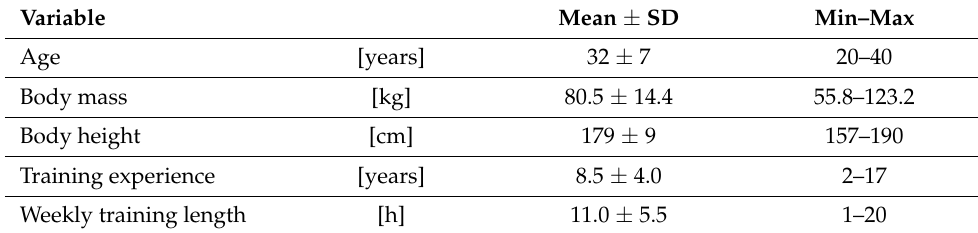
Figure 1. Flow chart of the study design. Table 1. Characteristics of the tested group after enrolment in the